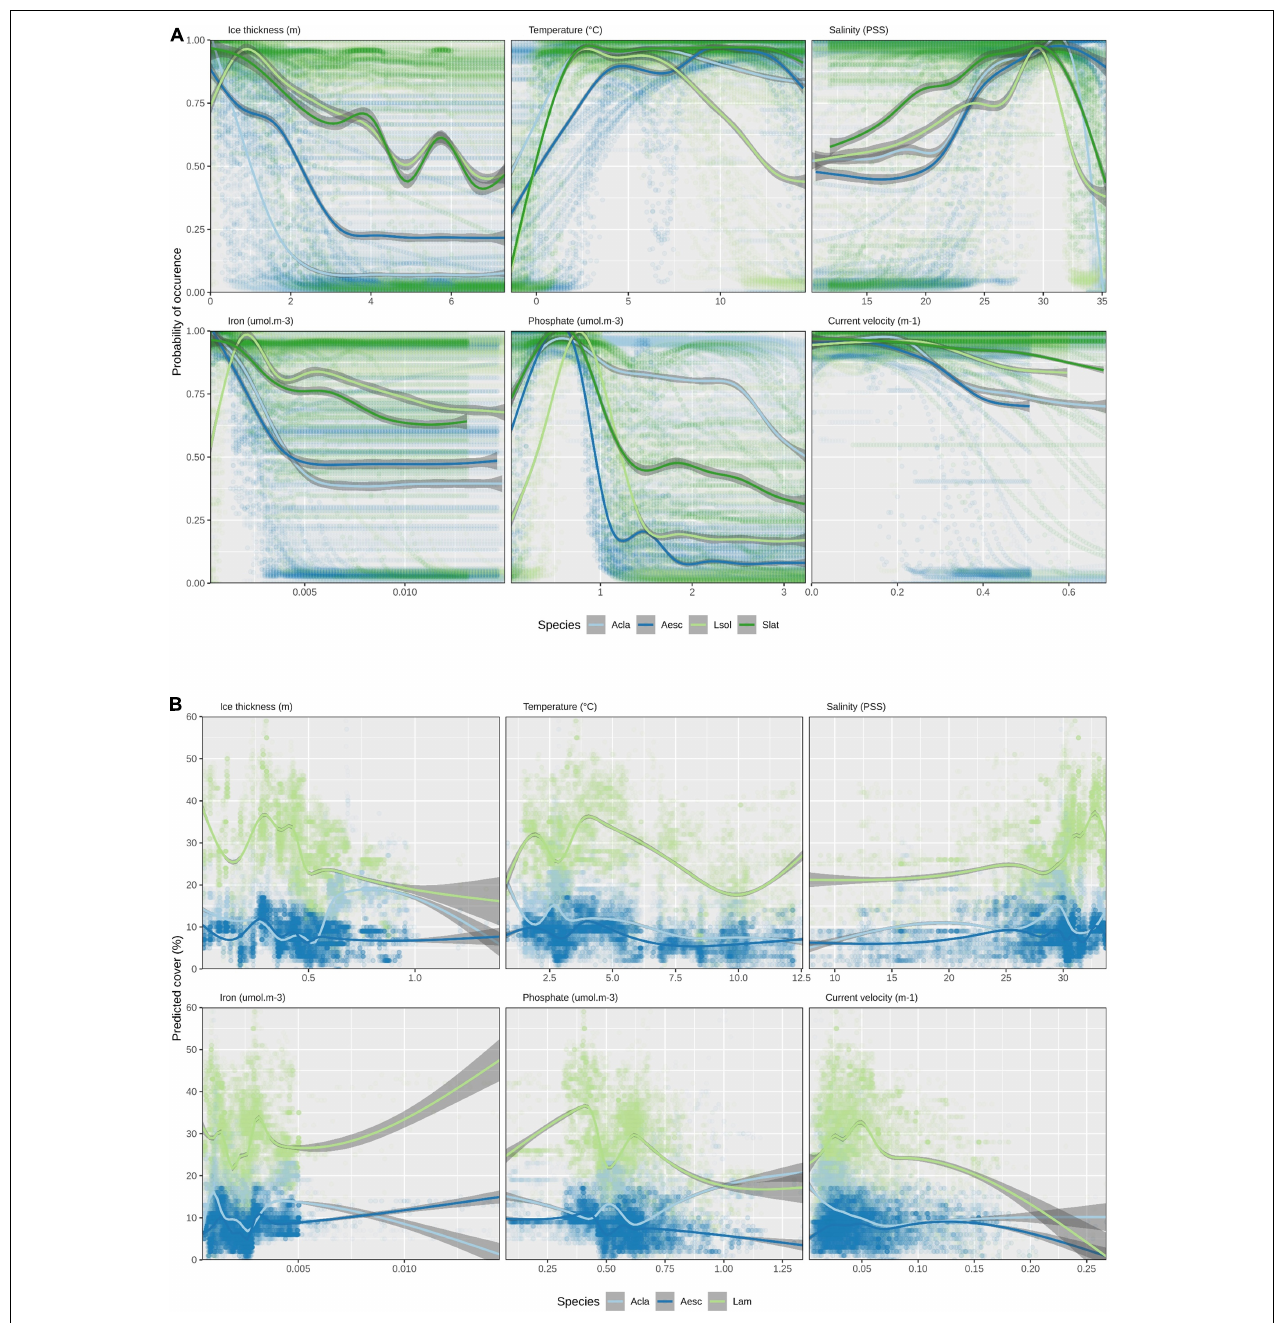
FIGURE 3 | Environmental response curves (generalized additive model) across all species and models. (A) Ensemble models for habitat suitability and (B) Random Forest for percent cover (Mean ice thickness, maximum surface temperature, mean surface salinity, mean bottom iron, mean bottom phosphate, mean bottom current velocity). Acla, Agarum clathratum ; Aesc, Alaria esculenta ; Lsol, Laminaria solidungula ; Slat, Saccharina latissima ; Lam, Laminariaceae. Note that values for the X - and Y -axes differ between the (A) ensemble and (B) Random Forest model panels and that the species shown between the two modeling approaches differ, as explained in the methods. The standard error for the GAMs are shown as dark gray